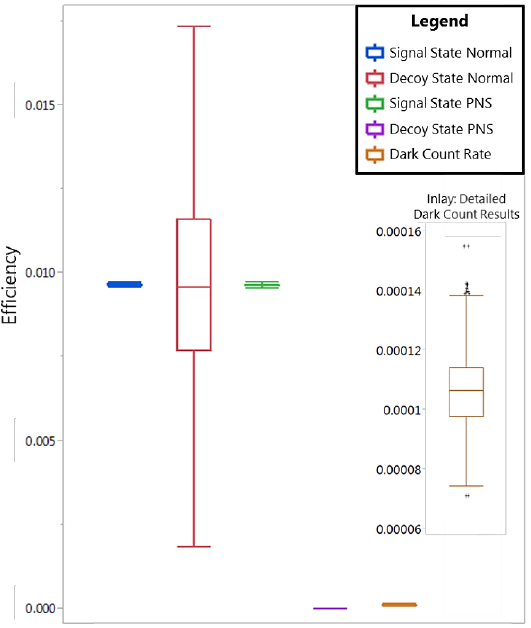
Figure 6. Simulation results show the optimized decoy state protocol for detecting PNS attacks based on the fielded QKD system [55]. The inlay details the expected dark count rate complete with outliers to illustrate the modeled noise over the QKD communication channel.